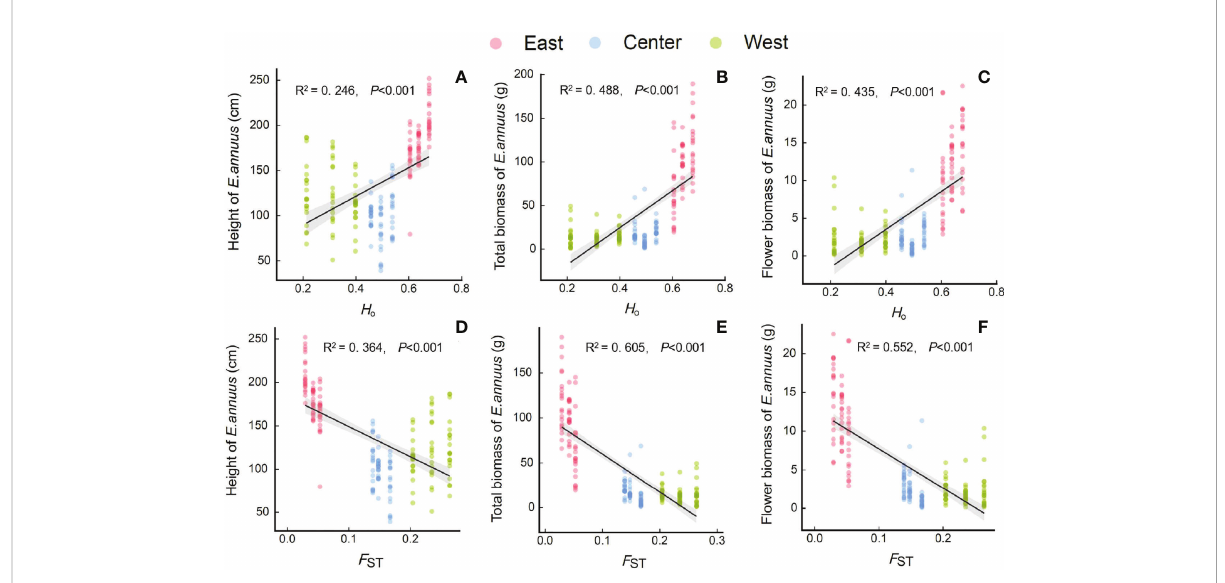
FIGURE 4 Relationships between genetic diversity and differentiation [ (A-C) H o , observed heterozygosity; (D-F) , F ST , genetic differentiation index] with height (A, D) , total biomass (B, E) and fl ower biomass (C, F) of E. annuus geographic populations in different regions in China. Similar symbols are different sites within the same